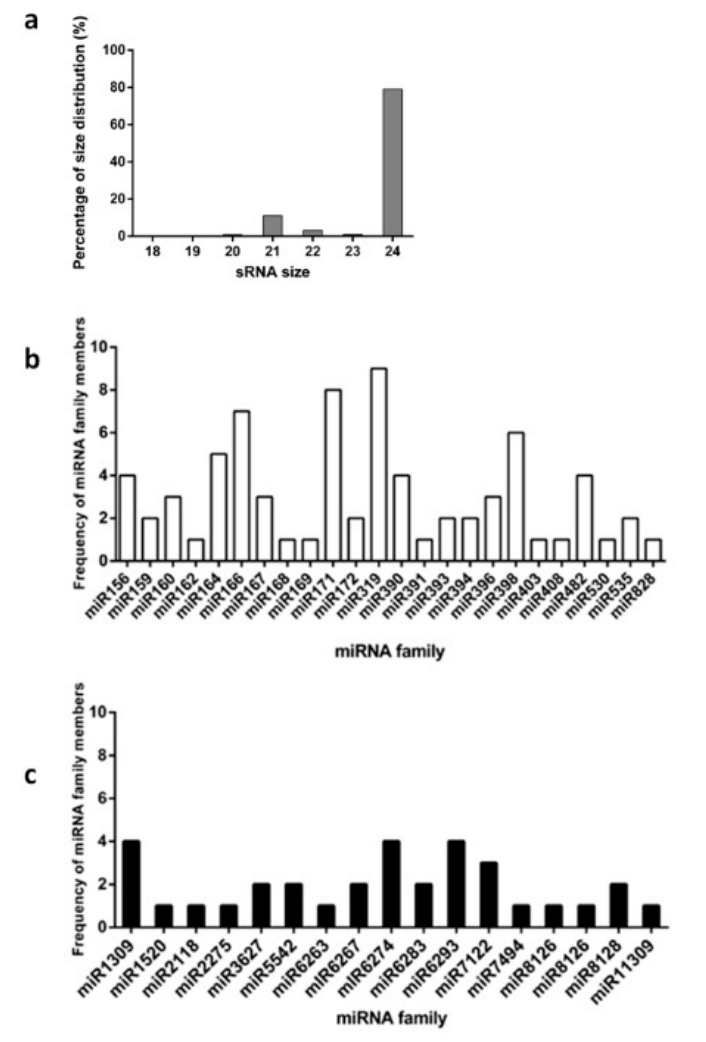
Figure 1. Small RNA next-generation sequencing results and miRNA identification in sweet cherry floral buds during chilling accumulation. Bing floral buds were used as the sRNA source for progres- sive chilling accumulation under field chilling (natural cold accumulation in the field) conditions. ( a ) Percentage of size distribution of total sRNAs identified with lengths of between 18- and 24-nt. Distribution of highly conserved ( b ) and conserved ( c ) miRNA families.